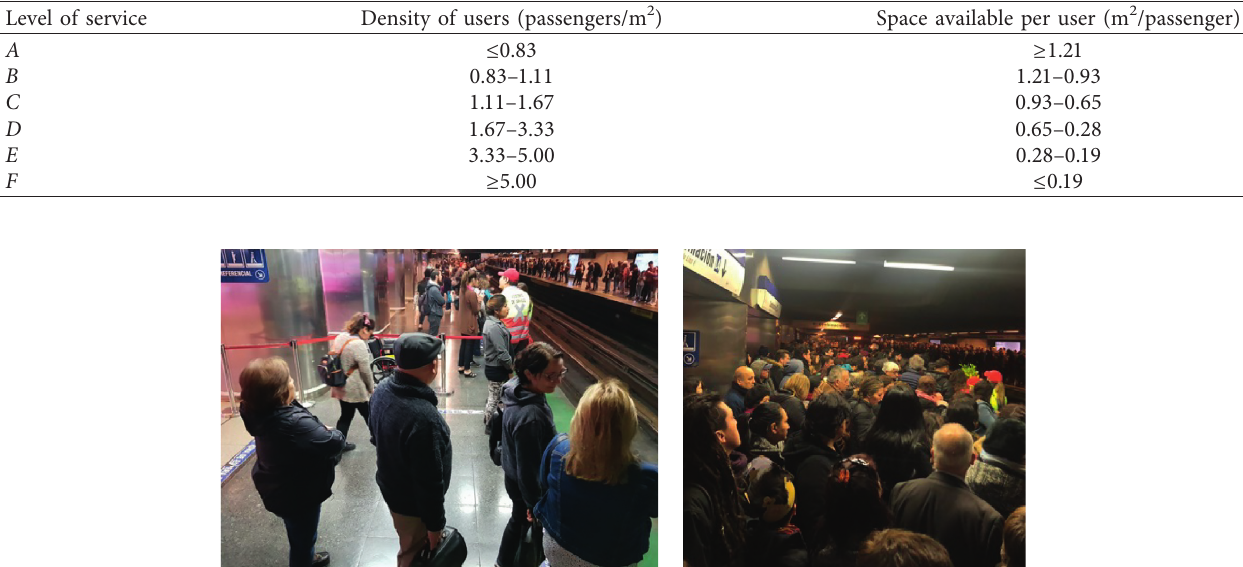
Table 1: Density values and available space in waiting areas reported in [29].